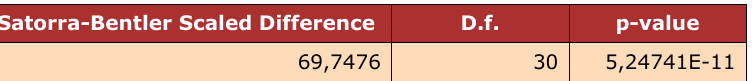
Table 7. Difference of adjusted Satorra-Bentler Chi Squared indexes